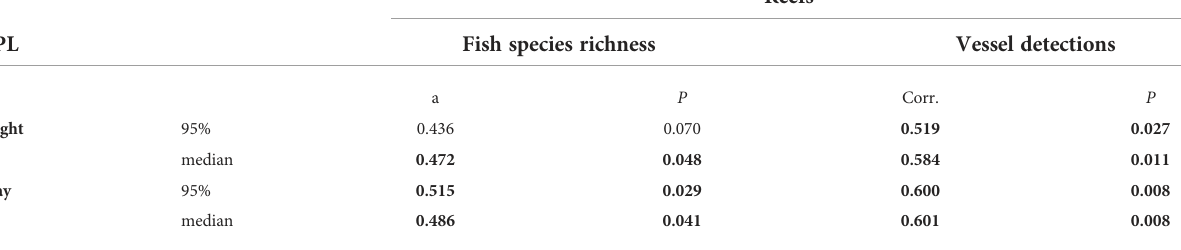
TABLE 5 Pearson correlation tests between SPL RMS (median and 95 th percentiles) and fi sh species richness among reefs and between SPL RMS and vessel presence [daily detections of idling boats among reefs from Boyle et al. (2022)] among reefs. Reefs SPL Fish species richness Vessel detections a P Corr. P Night 95% 0.436 0.070 0.519 0.011 Day 95%